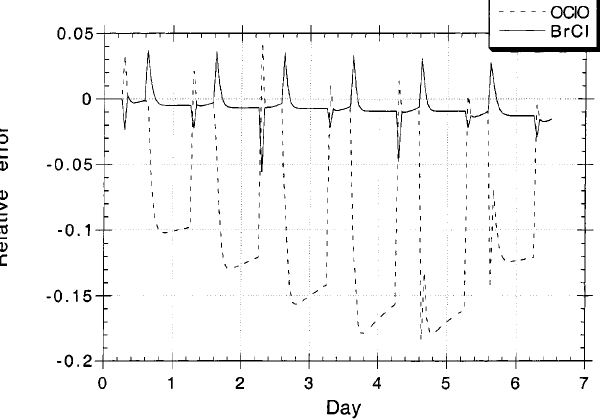
Fig. 3. Relative error for OClO and BrCl defined as (VODE- IMPACT)/VODE where the VODE run with families is used ( long dashed curve in Figs. 1 and 2). Dashed curve is OClO and solid curve is